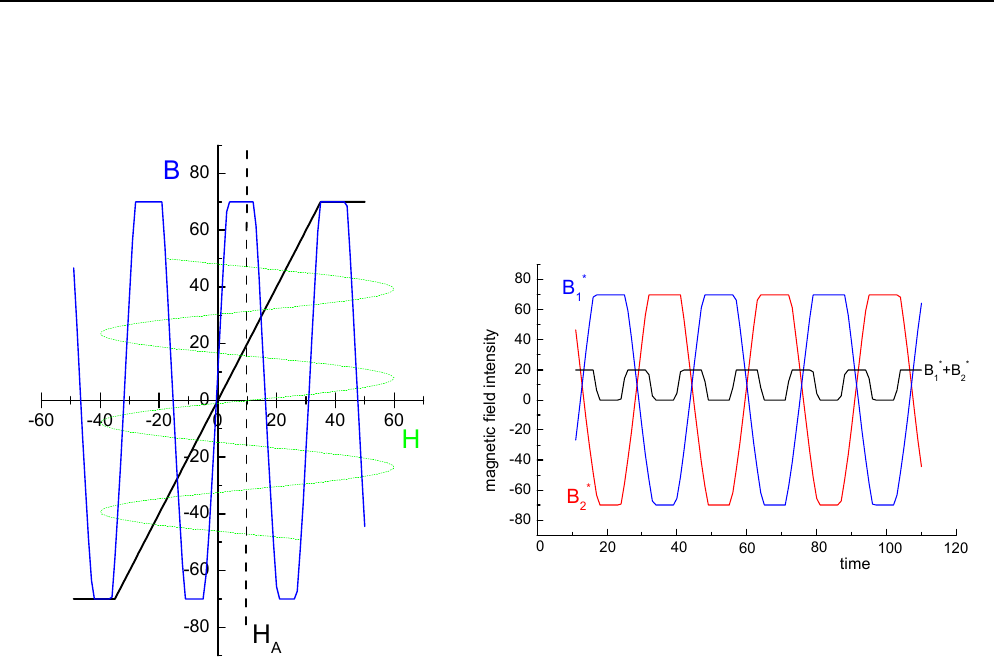
Figure 125: Left panel: the net effect of an ambient field 𝐻 A is that of introducing an offset which will break the symmetry of 𝐵 with respect to the zero line. This figure has to be compared with Figure 124 when no ambient field is present. The upper side of the 𝐵 curve saturates more than the lower side. An opposite situation would be shown by the second element. Right panel: trace of the resulting magnetic field 𝐵 = 𝐵 1 + 𝐵 2 . The asymmetry introduced by 𝐻 A is such that the resulting field 𝐵 is different from zero.